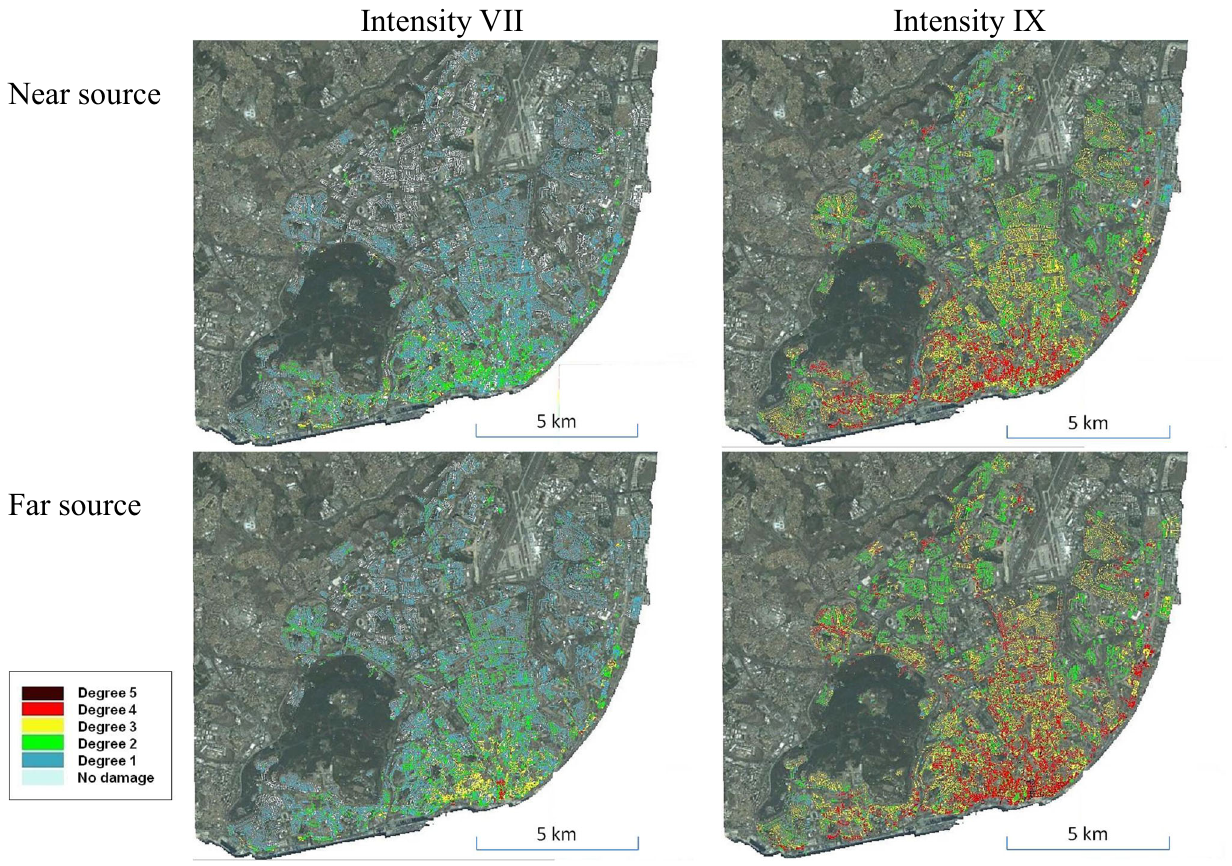
Fig. 5 Building damage spatial distribution for different simulated seismic scenarios in Lisbon. Images are north